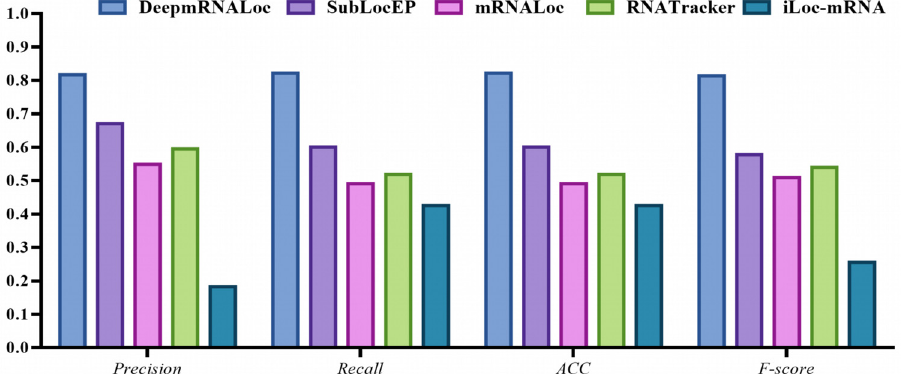
Figure 1. Performance comparison of DeepmRNALoc, SubLocEP, mRNALoc, iLoc-mRNA, and RNATracker under different evaluation indicators. Table 4. Comparison of accuracy between DeepmRNALoc and SubLocEP based on Dataset 2.